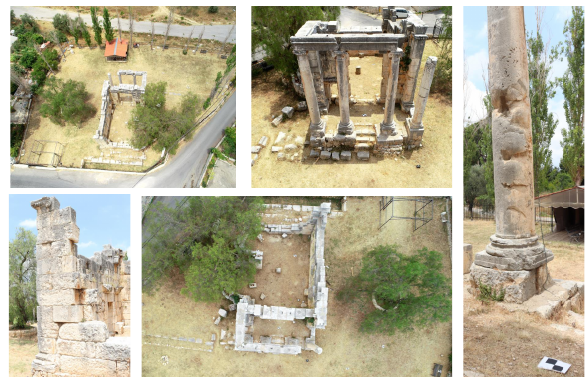
Figure 2. The Bziza site and its Roman temple. Details of the images acquired during terrestrial and aerial photogrammetric surveys.